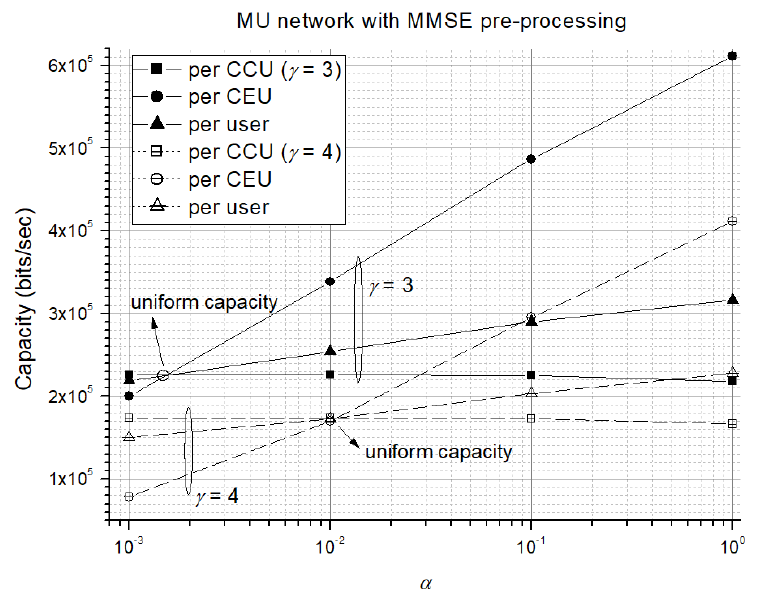
Figure 10. Capacity comparison between different values of path loss exponent γ for MU-network MIMO with MMSE joint preprocessing.